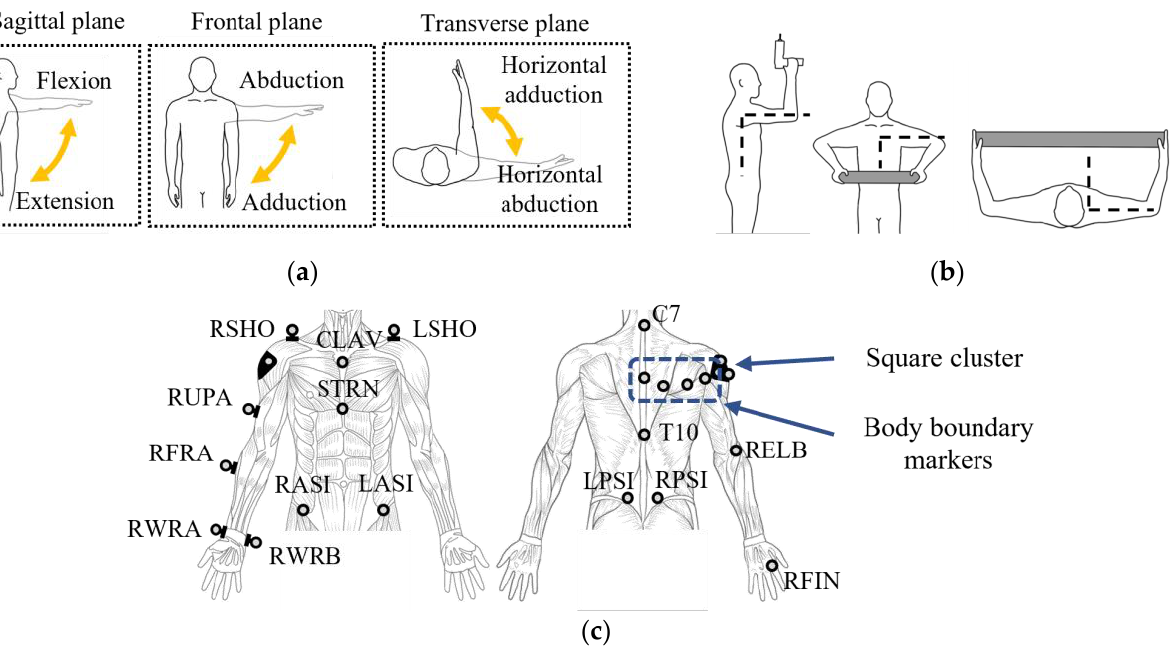
Figure 1. Experimental setup: motions and attached markers: ( a ) Representation of three basic 1-degree of freedom (DOF) movements of the shoulder. ( b ) General work-related motions performed in the industry. ( c ) Position of the recorded markers and cluster. The labeled markers represent the plug-in gait marker set; the blue box represents the body boundary markers.